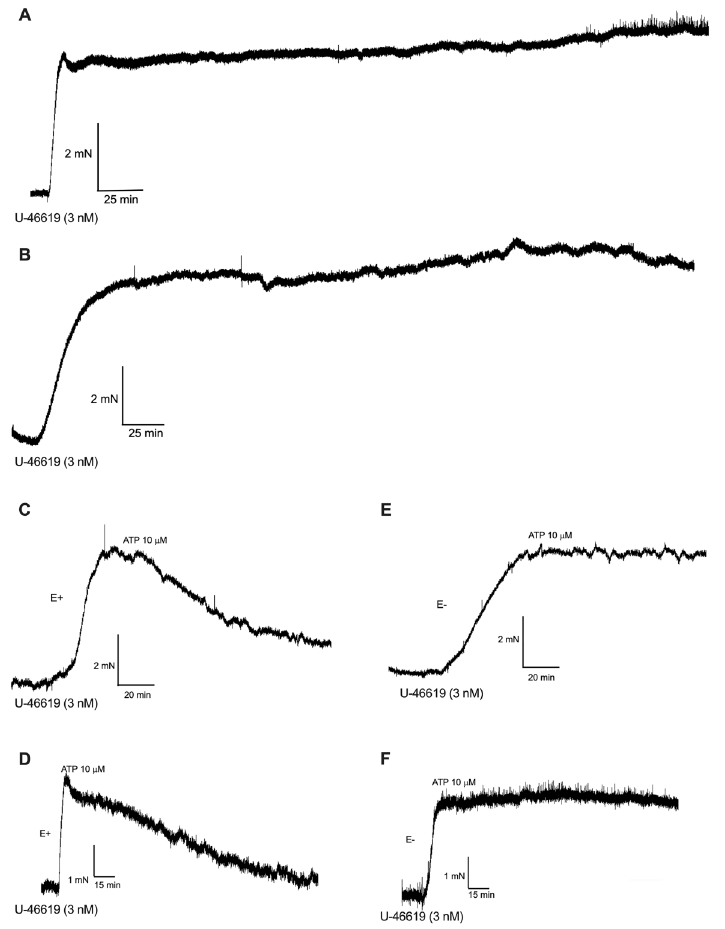
Figure 2. Contractions induced by U-46619 of marmoset arteries. The endoperoxide analogue U-46619 (3 nM) induced a stable and durable contraction of both thoracic aorta ( A ) and pulmonary artery ( B ) rings. In endothelium-intact thoracic aorta ( C ) and pulmonary artery ( D ) rings, pre-contracted with U-46619 (3 nM), adenosine triphosphate (ATP; 10 m M) caused relaxations that were not observed when the endothelium was mechanically removed from the thoracic aorta ( E ) and pulmonary artery ( F )